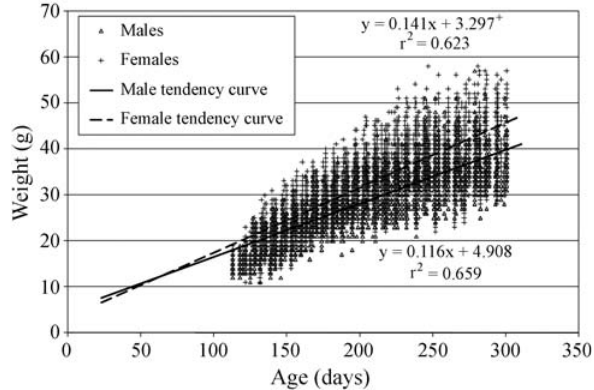
Figure 1 - Relationship between the weight of male and female Litopenaeus vannamei according to age. The equations and regression co-